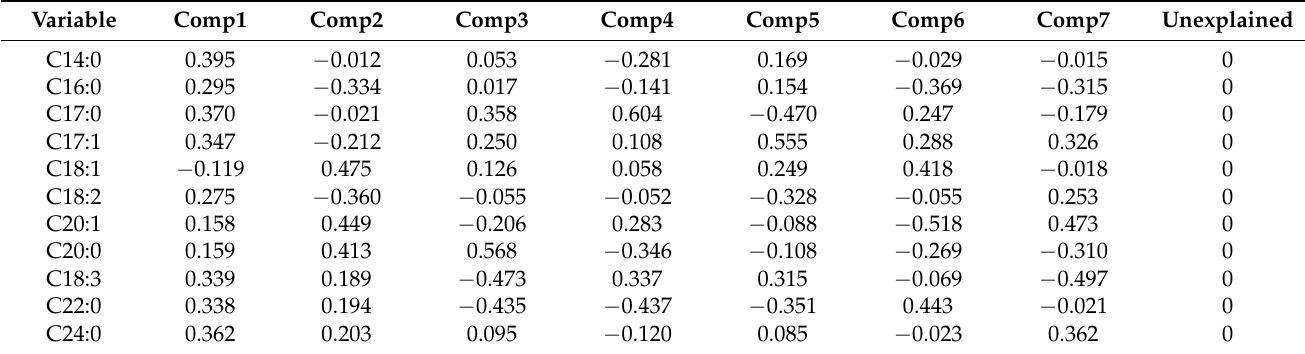
shows all the component loadings of the fatty acids of EVOOs. Table 9. Component loadings of the fatty acids of EVOOs.